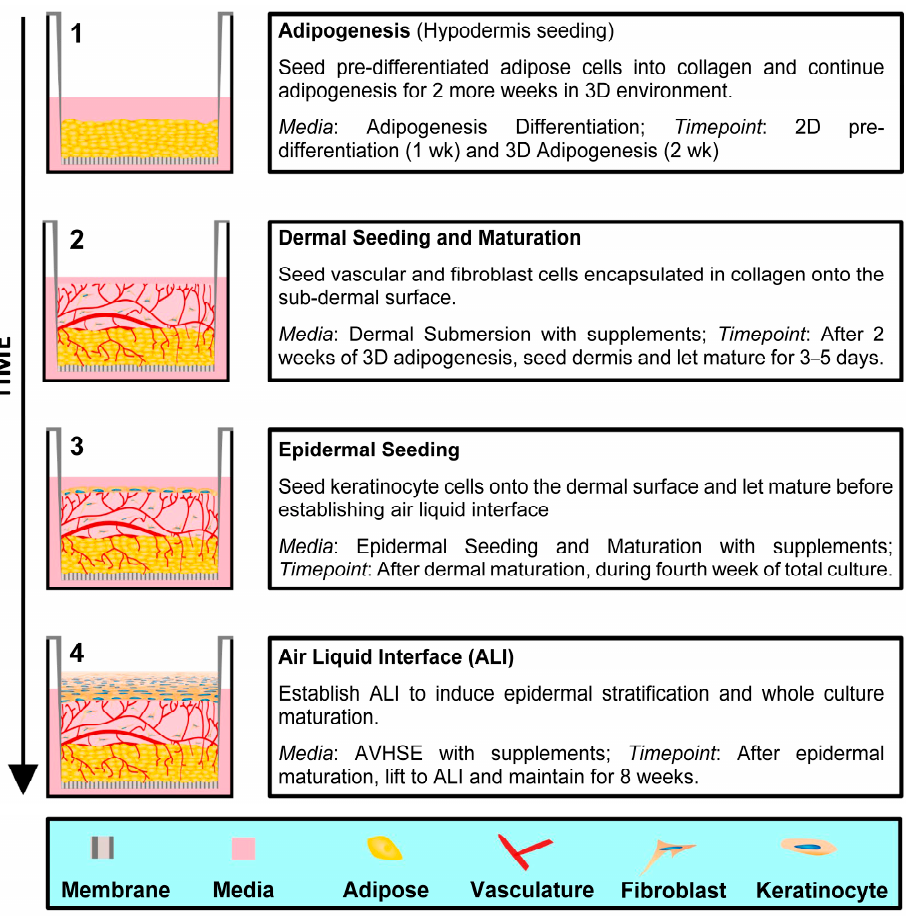
Figure 1. AVHSE generation. There are four main steps in creating an AVHSE: (1) Adipogenesis, (2) Dermal seeding and maturation, (3) Epidermal seeding, and (4) Air liquid interface. Cartoons on the left show cross-sectional representations of AVHSE during each step.